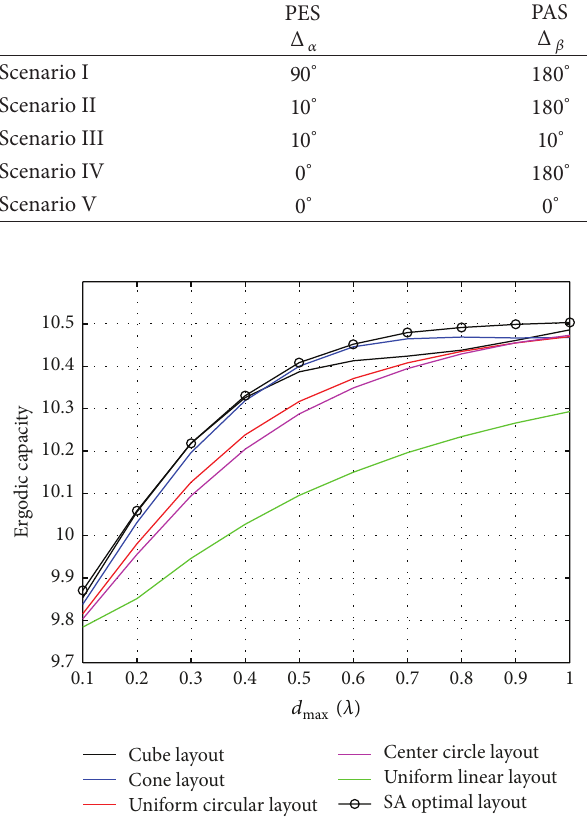
Figure 4: Capacity difference between the optimal layout and the reference regular layouts for Scenario I with 𝛾 0 = 20